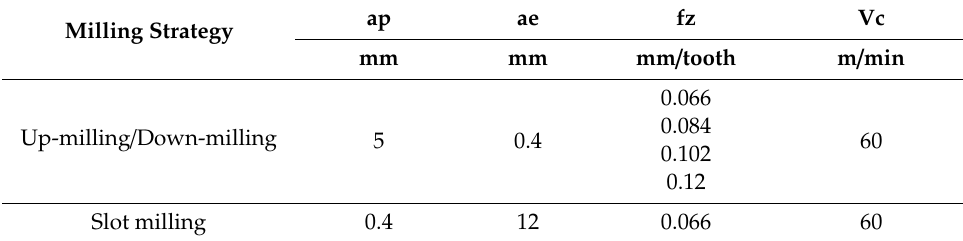
Table 2. Cutting conditions in the feed speed and milling strategy tests.